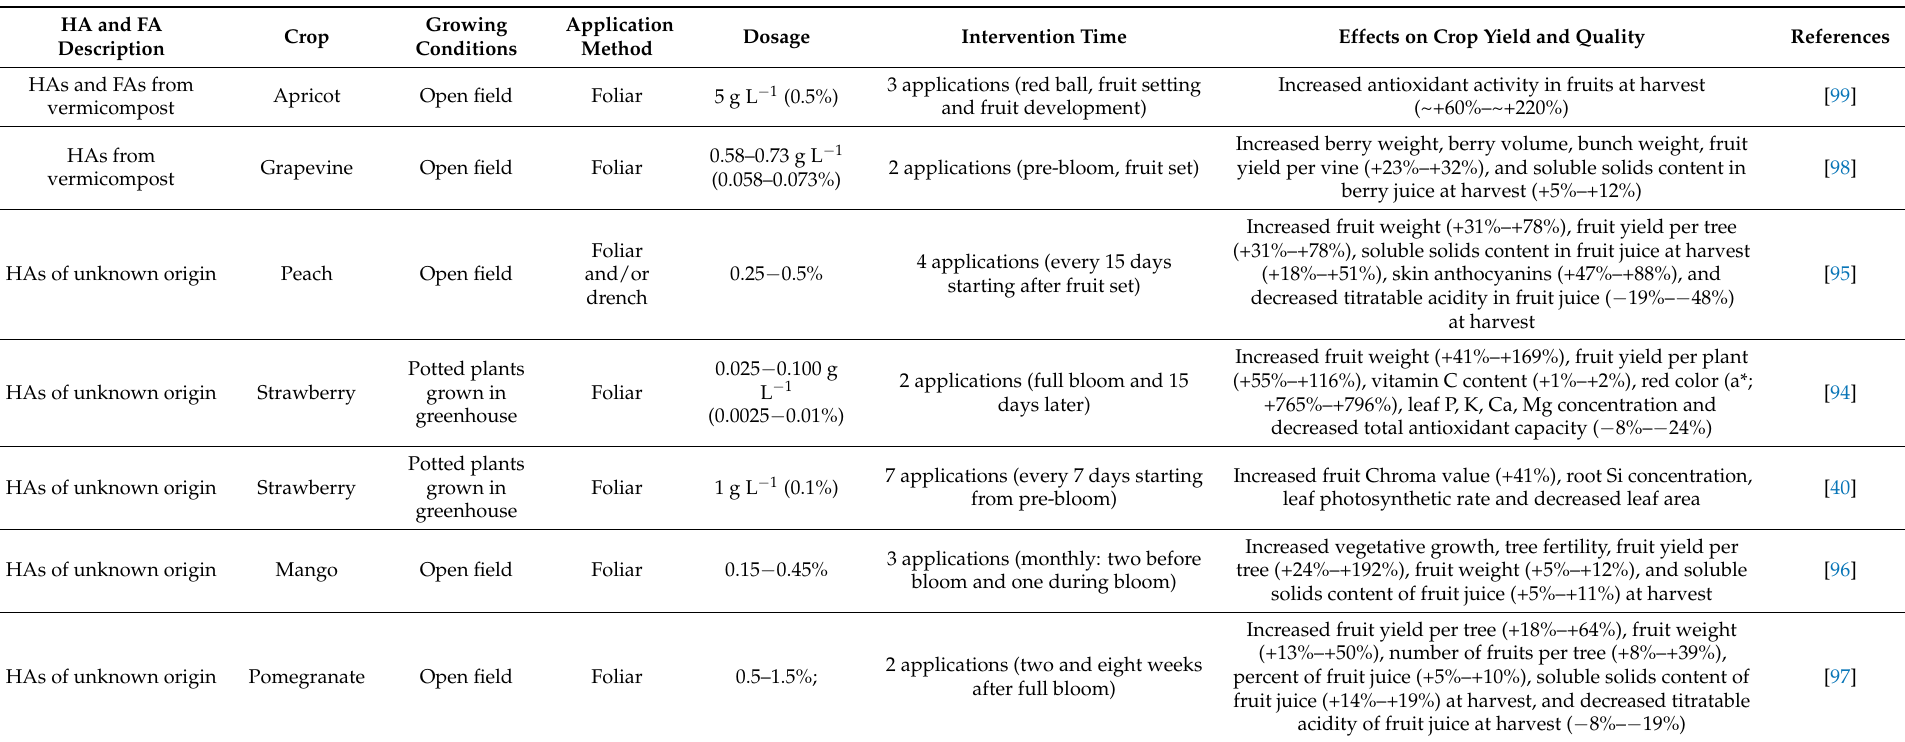
Table 9. Humic and fulvic acid (HA and FA respectively) application methods to increase yield and product